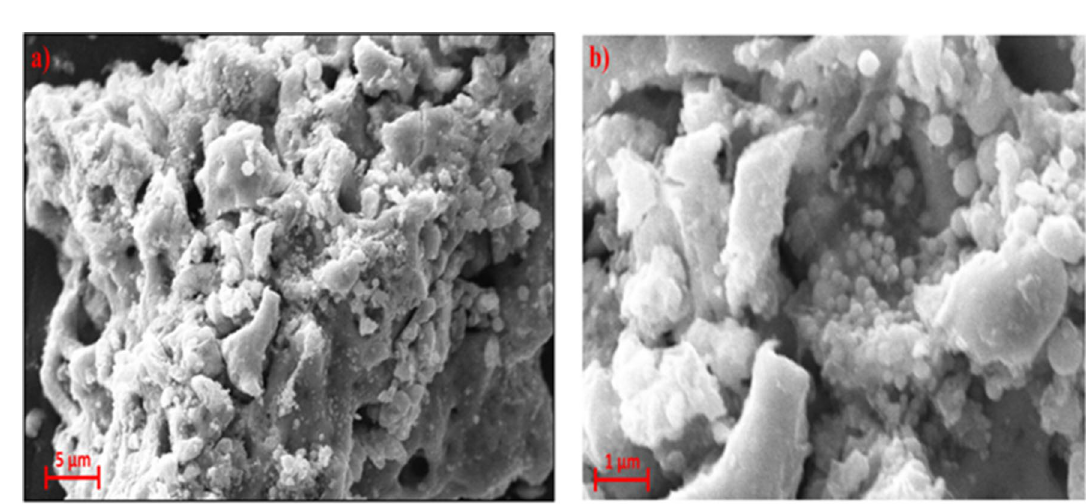
Figure 2. Different magnification of ( a , b ) rapid synthesized SeNPs FE-SEM images ( a ) 5 µm, ( b ) 1